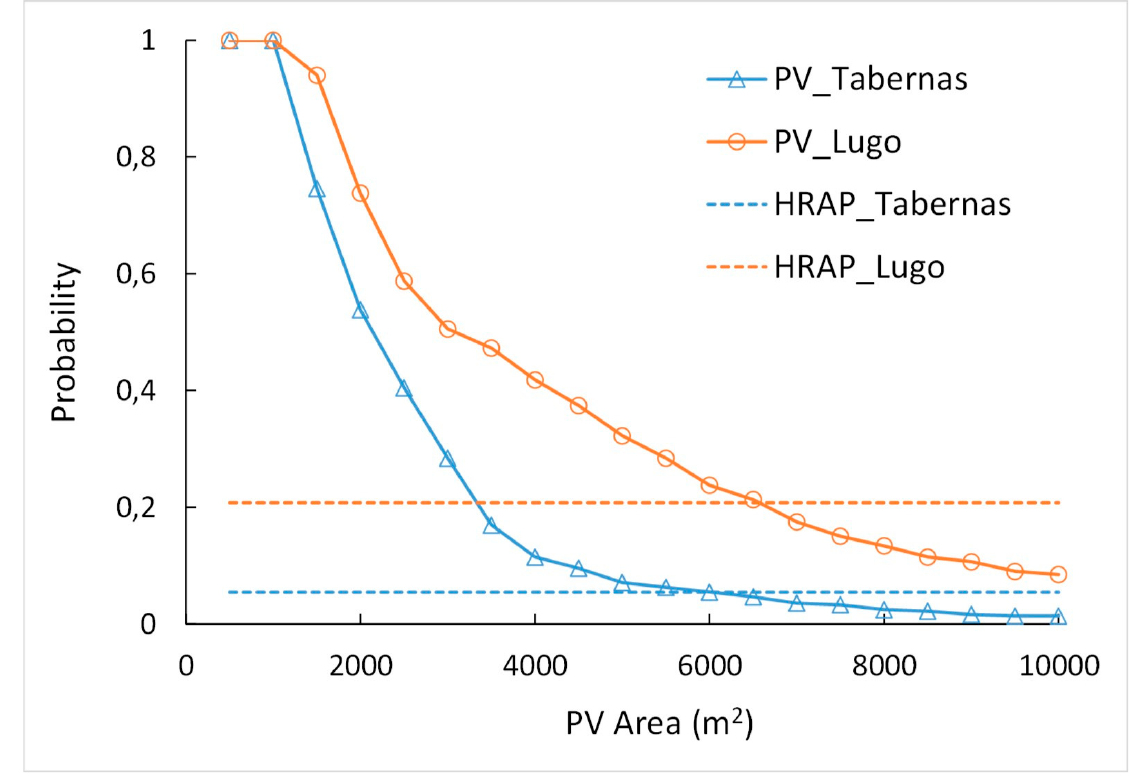
Figure 3. Probability of not meeting the energy consumption threshold at least one day.